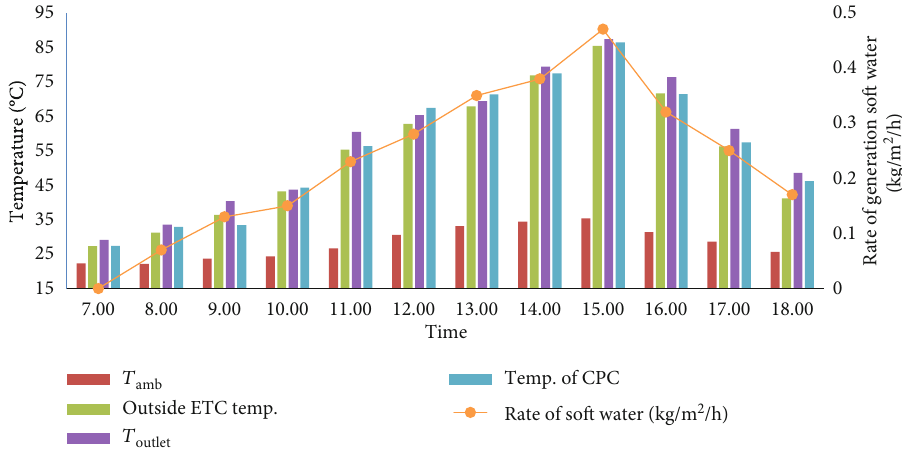
Figure 7: Variations of the rate of generation and measuring temperatures versus time (re fl ective white